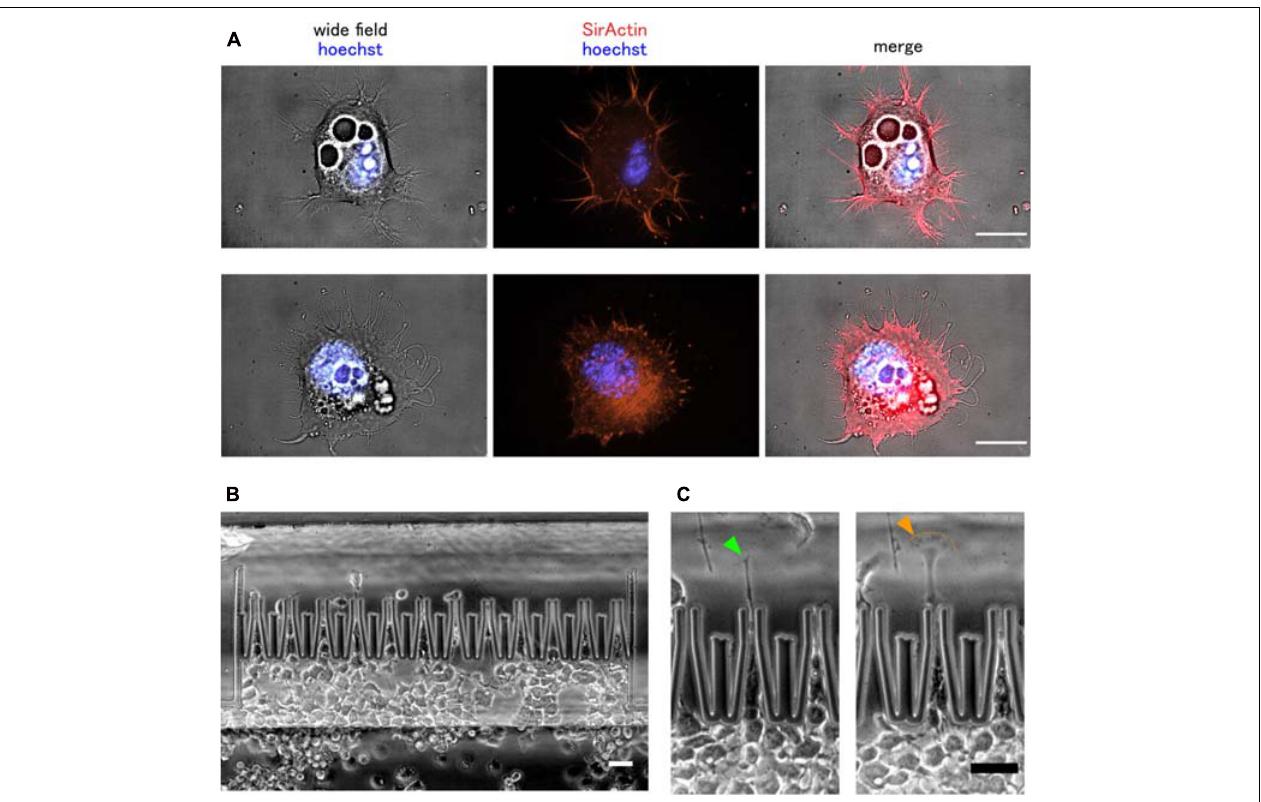
FIGURE 5 | Murine neuronal cancer cell migration through narrow micro-constrictions. (A) Wide field and fluorescent images of two NG108-15 cells. These cells grown in 2D culture exhibit spontaneous, microtubule-driven neurite growth. Importantly, actin can still be found within the neurite protrusions, not only at their tips. Actin filaments are shown in red, nuclei are shown in blue. Scale bar is 20 µ m. (B) Overview of the cell migration into the chip, (C) growth of one main neurite protrusion was observed in NG108-15 cells actively migrating through the micro-constrictions. The cell neurite exhibited a dynamical behavior during the squeezing phase, with its growth cone morphology alternating multiple times between a tight, thread-like configuration (green arrow) and a more flattened, lamellipodial-like configuration (orange arrow). Scale bar is 50 µ